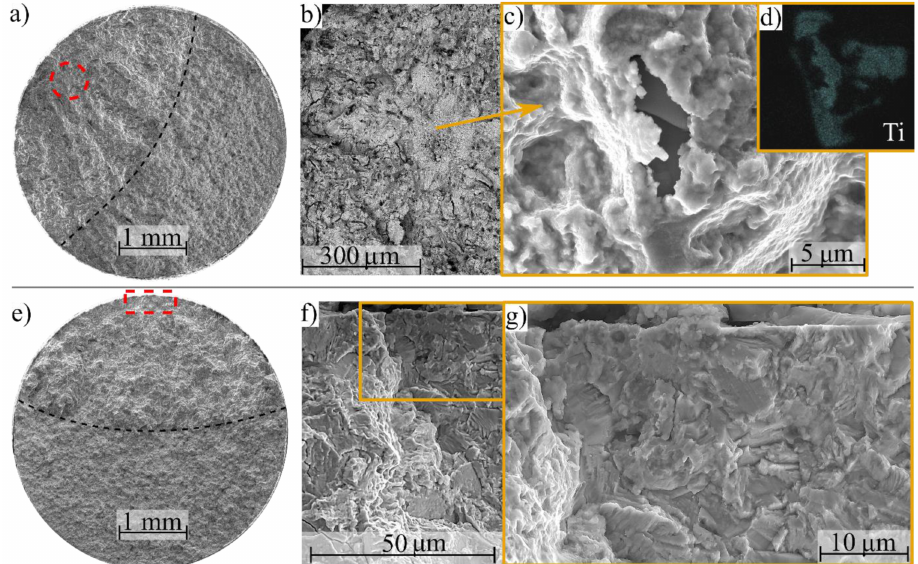
Figure 9. Fracture surface observations on the REF material using SEM. ( a ) Overview of a sample tested at σ a = 530 MPa and N f = 5.6 × 10 7 that failed due to an internal defect (red circled area). ( b ) BSE image of an internal defect. ( c ) Detail of the internal defect. ( d ) EDS map of an internal defect (Ti). ( e ) Overview of a sample tested at σ a = 530 MPa and N f = 4.2 × 10 7 that failed from the surface (red rectangle area). ( f ) Area of crack initiation. ( g ) Detail of the area of crack